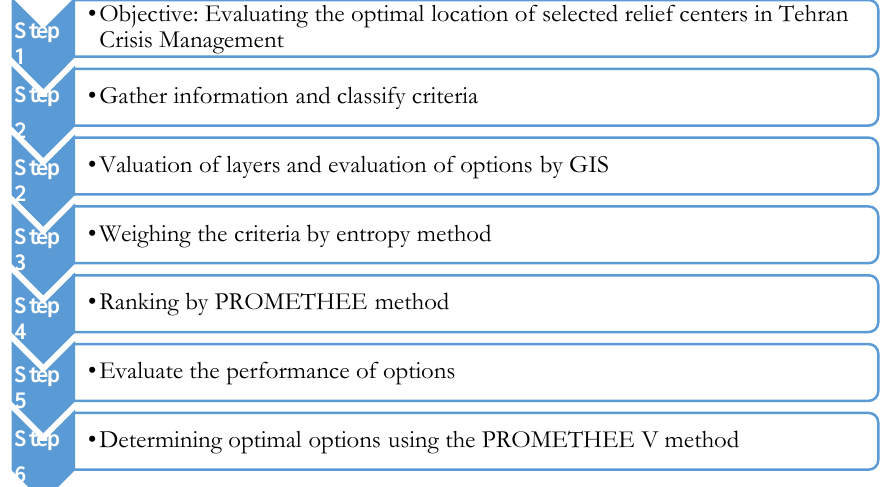
Fig. 1. The general structure of the